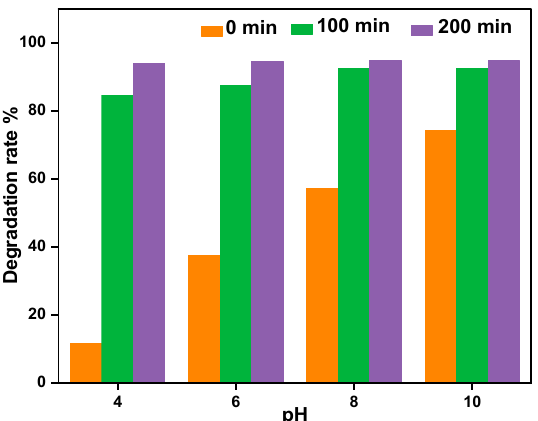
Figure 8. The MB degradation efficiency over the MgSiNS-GN20 nanocomposite at different pH solutions using visible light irradiation.